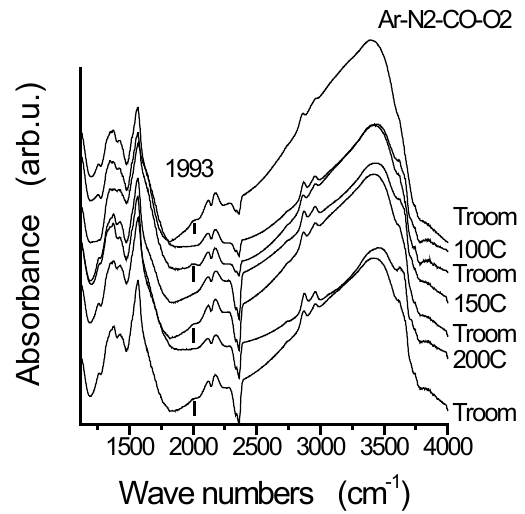
Figure 6. DRIFT spectra of the initial biomass sample collected in gas mixture of Ar+N +CO+ О at various 2 2